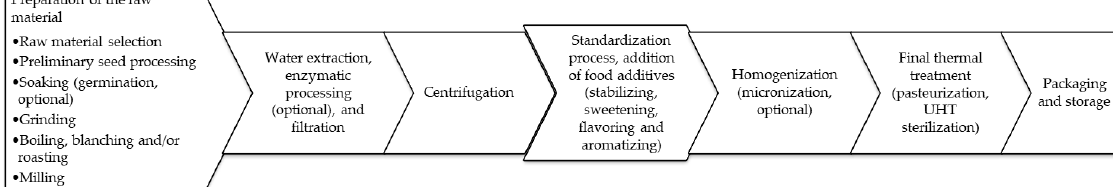
Figure 1. The most important processes of the production of cereal and pseudocereal beverages (details are in the text). The first stage is the preparation of the raw material for processing. For example, if seeds are the raw material, then following the removal of contaminants, they are soaked, filtered, and flushed. In the case of cereals and pseudocereals, they are first arched, clas- sified, and washed. During preliminary seed processing, the physical barriers are re- moved and the fiber content is changed to access hydrolytic enzymes and increase the speed of hydrolysis [38]. For some raw materials, prior to soaking and grinding, addi- tional blanching and/or roasting is performed (Figure 1). Blanching is usually carried out in boiling water for 1 – 5 min, and its purpose is to prevent the emergence of foam on the drink during the further process. Roasting is done at temperatures above 100 °C, in hot air. Depending on the type of raw material and temperature used, the time of roasting varies. This process allows improving the taste and aroma of the final product, but can reduce protein solubility and extraction efficiency [13]. Soaking and milling prepare the raw material for further stages and facilitate the release of nutrients contained within the material therein. Water inactivates some inhibitors and reduces the amount of phytic acid, which increases the absorption of nutrients and their bioavailability [13,35 – 37,39]. The prepared seeds or grains of cereals and pseudocereals are subjected to extraction and filtration (Figure 1) [40,41]. Filtration, centrifugation, and homogenization result in the final beverage characterized by stable consistency. For cereal beverages, processes such as enzymatic treatment, decanting, and homogenization are applied further [15,35,40,41]. Enzymatic processing (swinging, germination, addition of enzymatic prep- arations) is carried out, among other processes, to enable the distribution of oligosaccha- rides and non-starch polysaccharides that are responsible for the ideal consistency of bev- erages, as well as starch distribution [36,42 – 49]. In the case of some plant raw materials, enzymes are also added at this stage, to activate the enzymatic hydrolysis of starch or other polysaccharides. One such enzyme is alpha-amylase, which catalyzes the hydrolysis of α -1,4-glycoside amylose and amylopectin in starch, and produces compounds with shorter chains, mainly dextrins. Proteolytic enzymes that can enhance the protein solubil- ity and efficacy of extraction and improve the stability of water suspension are also used [13,50]. Alternatively, dry raw materials are pre-ground and then subjected to aqueous extraction at an elevated temperature [13,35]. During contact with water, the layout is ad- ditionally heated to induce starch hydrolysis. Starch gelatinization increases the viscosity of plant ingredients before fermentation and also prevents phase separation [51,52]. At this stage, the above-mentioned enzymes may be added to induce hydrolysis [13,39]. It should be noted that enzymatic treatment can modify the remaining noncarbohydrate in- gredients of plant beverages. Some researchers have reported that the germination of leg- ume seeds can influence the level of B vitamins [53,54]. Ziarno et al. [54] showed that the germination process modified the fatty acid profile of bean lipids. It can be assumed that a similar phenomenon may occur during the germination and swarming of the seeds of cereals and pseudocereals. Moreover, thermal treatment at high temperatures can change the positional distribution of fatty acids in plant triacylglycerol lipids [55]. The obtained plant-based beverage base is subjected to a standardization process to obtain a product with a previously assembled composition. The pH of the final beverage is determined, and appropriate buffering substances (e.g., phosphates) are used for